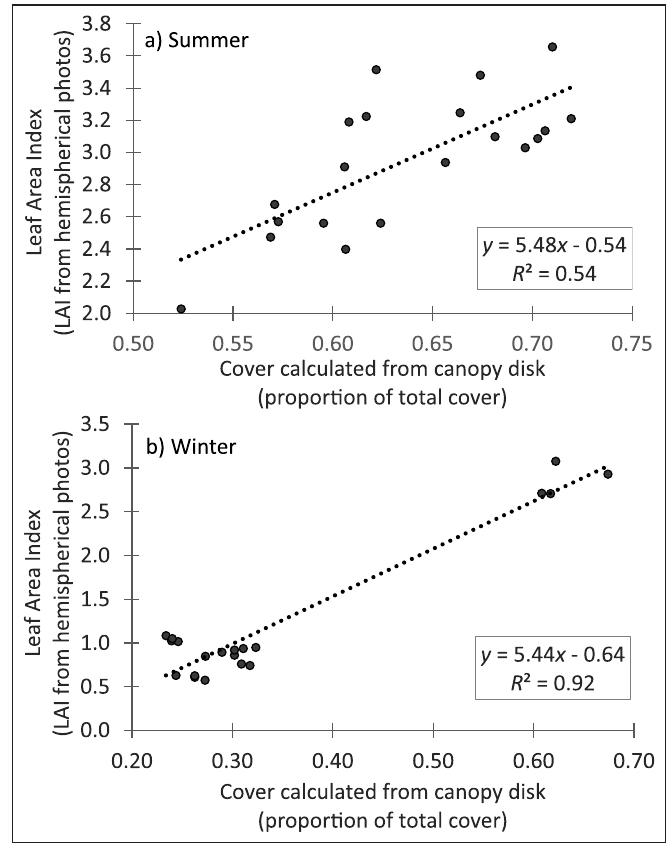
Figure 6 Calibration of the canopy disk through comparison of canopy cover calculated from the mean of the vertical and cardinal measurements against the leaf area index (LAI) calculated from hemispherical photographs (according to Hartikainen et al. 2018). Parallel measurements with the two approaches taken from four measurement points in five different forest stands in Viikki Arboretum, Helsinki, in (a) summer and (b)